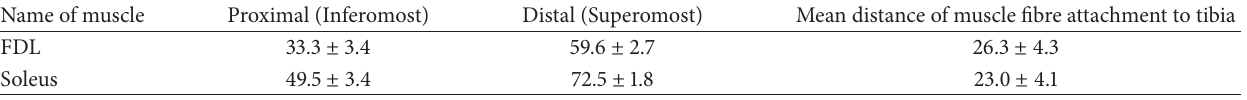
Table 1: The mean distance of the attachment of muscle fibres from the medial malleolus of tibia.